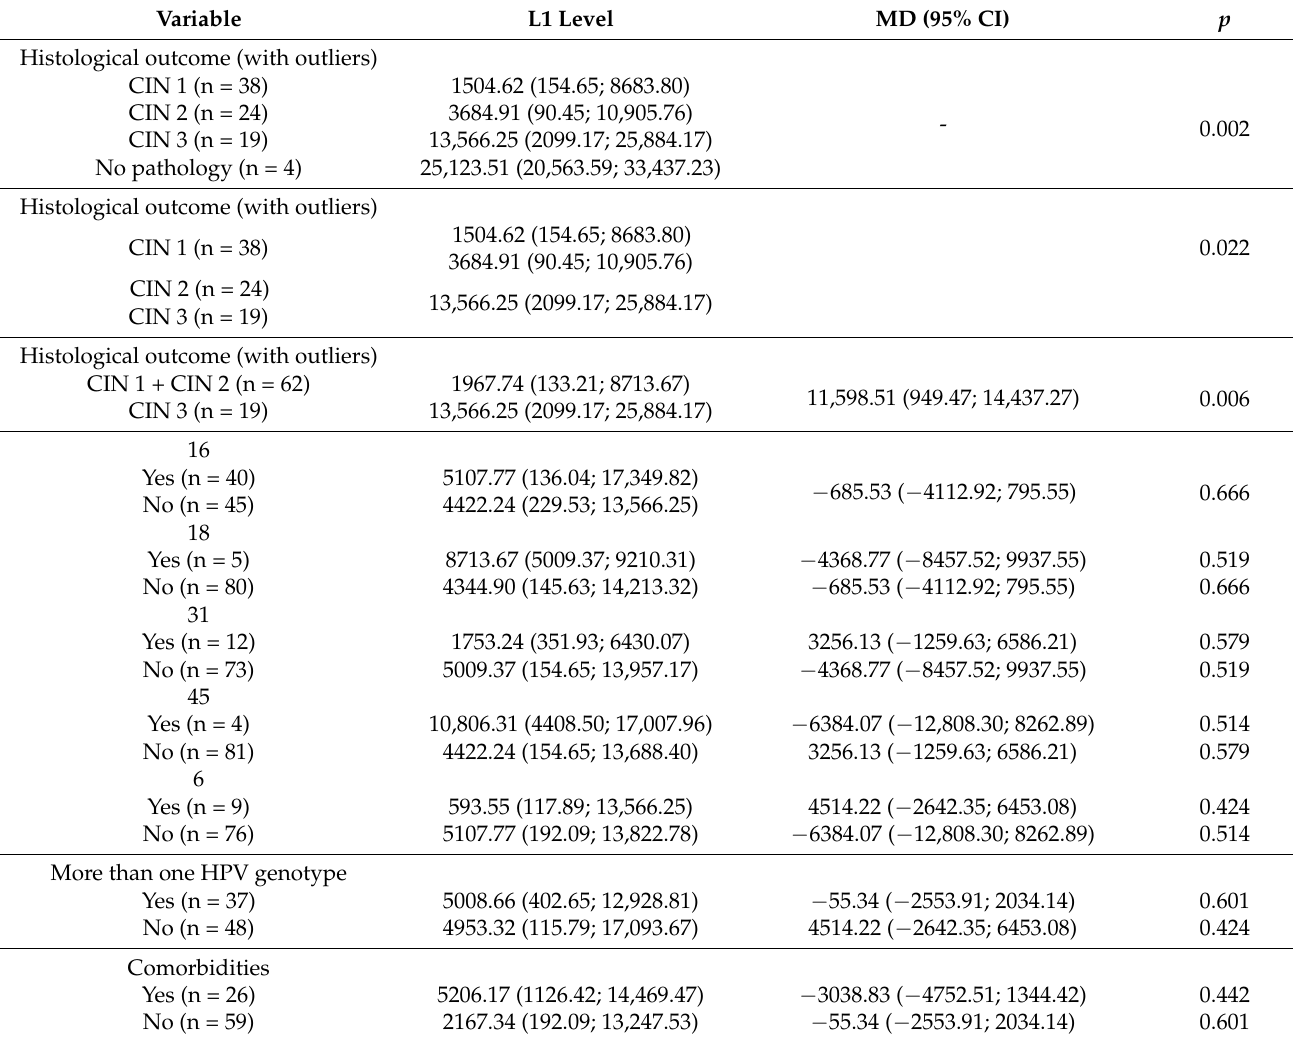
Table 3. Comparison of HPV L1 levels between selected